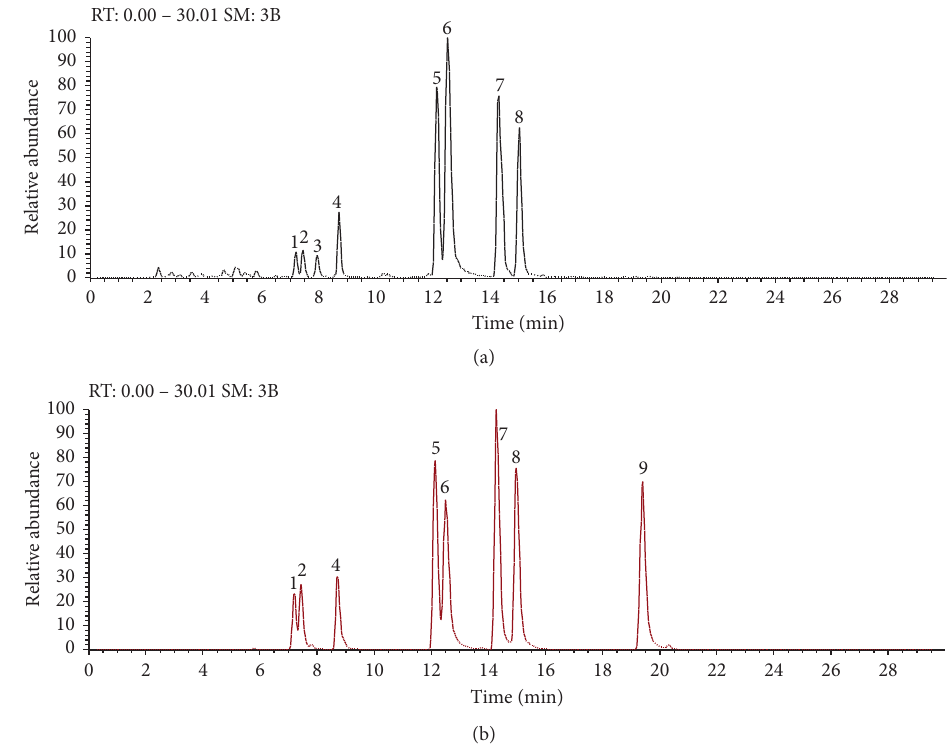
Figure 2: Extracted ion chromatogram (EIC) of the test sample (a) and mixed standard solution (b). (1) SSc, (2) SSi, (3) rotundioside D, (4) SSh, (5) SSa, (6) SSb 2 , (7) SSg, (8) SSb 1 , and (9)